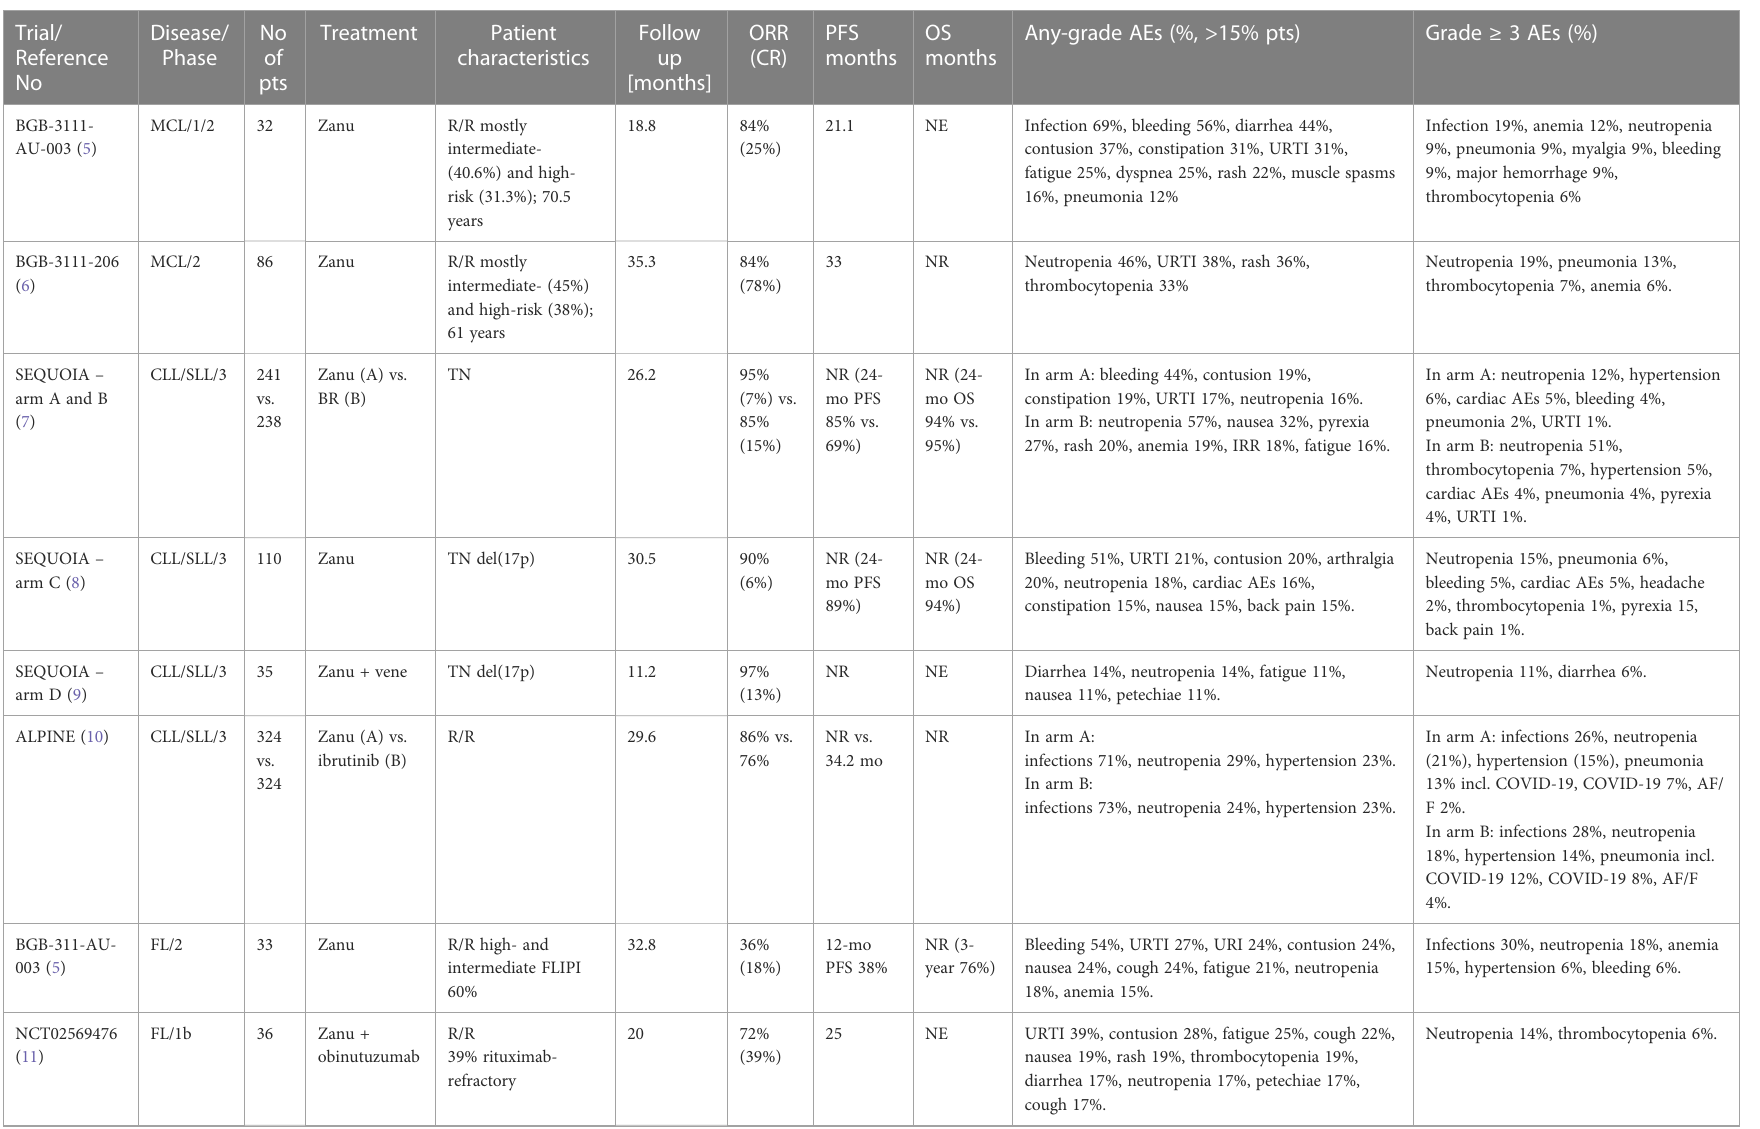
TABLE 1 Clinical trials of zanubrutinib in B-cell lymphoid